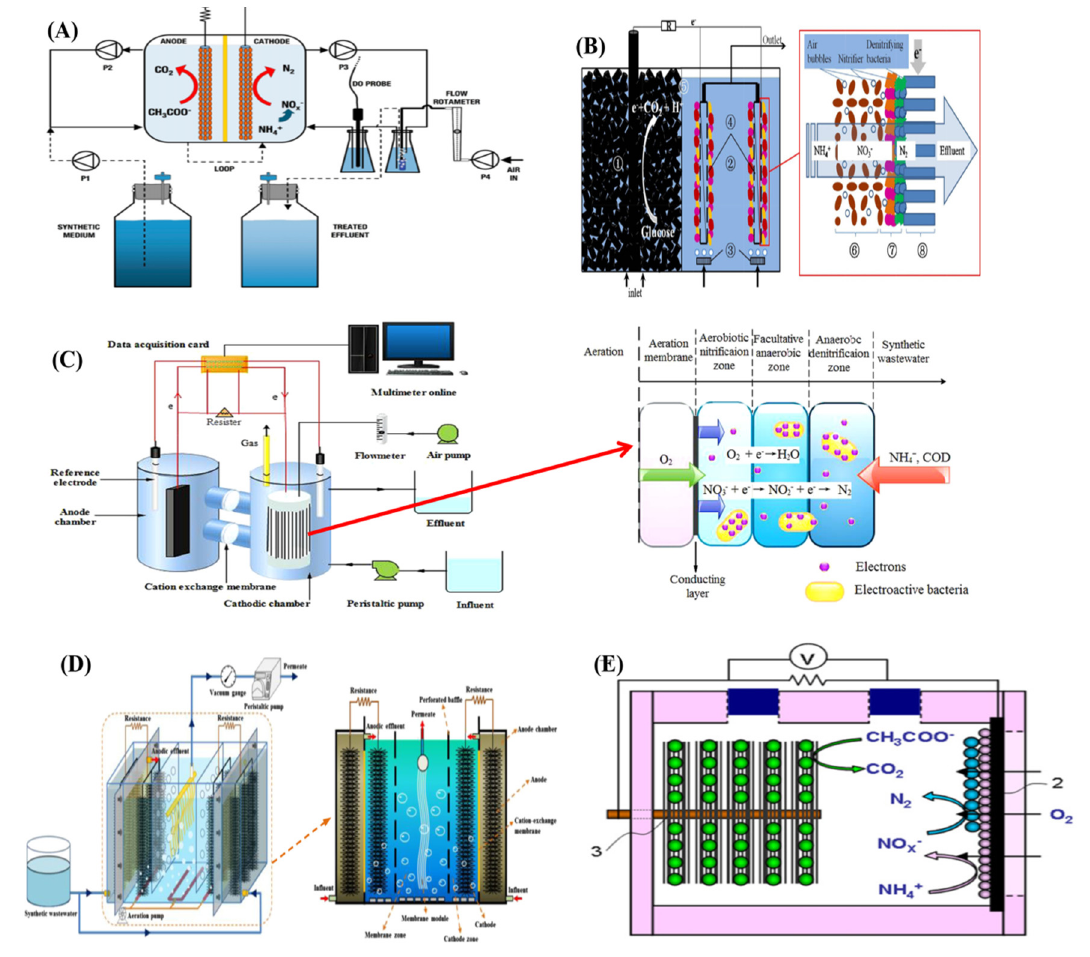
Figure 2. ( A ) Schematic representation of the experimental setup, dual-chamber microbial fuel cell (MFC) for simultaneous nitrification and denitrification [22]; ( B ) Schematic of the integrated system, and ammonium evolution in the cathode chamber. The reactor was equally divided into two chambers (an anodic anaerobic zone and a cathodic aerobic zone) by a Plexiglas baffle, biocathodes for simultaneous nitrification and denitrification [45]; ( C ) Schematic diagram of the EMA-MFC system, and nitrogen removal in the cathodic chamber [46]; ( D ) Schematic diagram of the MBER [47], and ( E ) single-chamber air-cathode MFCs for simultaneous nitrification and denitrification [34]. Reproduced with copyright, Elsevier and Springer Nature. Table 3. Efficiency of nitrogen removal via different process in Bioelectrochemical systems (BESs).